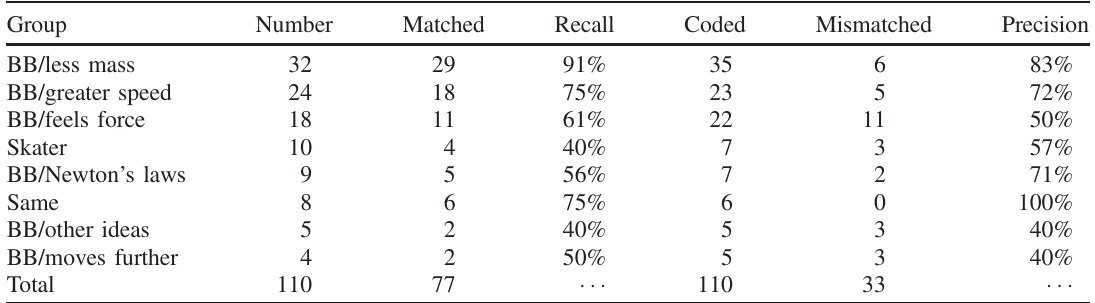
TABLE VII. Group-by-group matching for the ice skater and bowling ball (BB) activity.